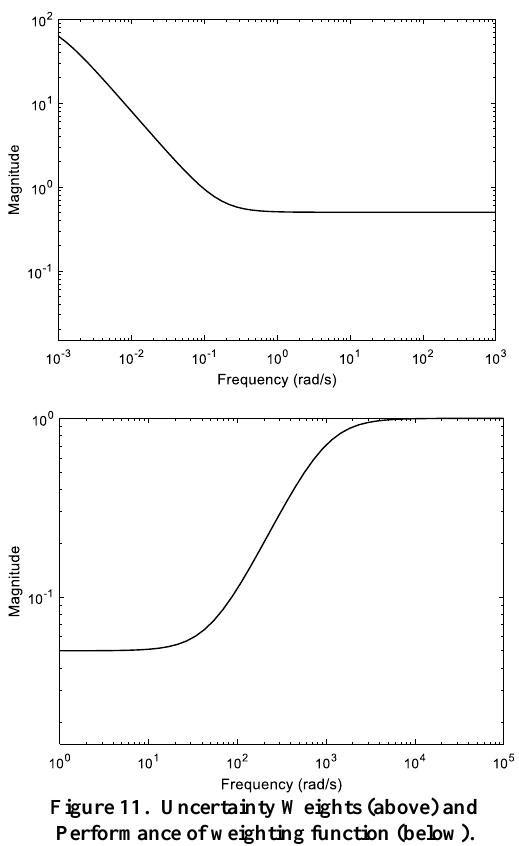
Figure 11. Uncertainty Weights (above) and Performance of weighting function